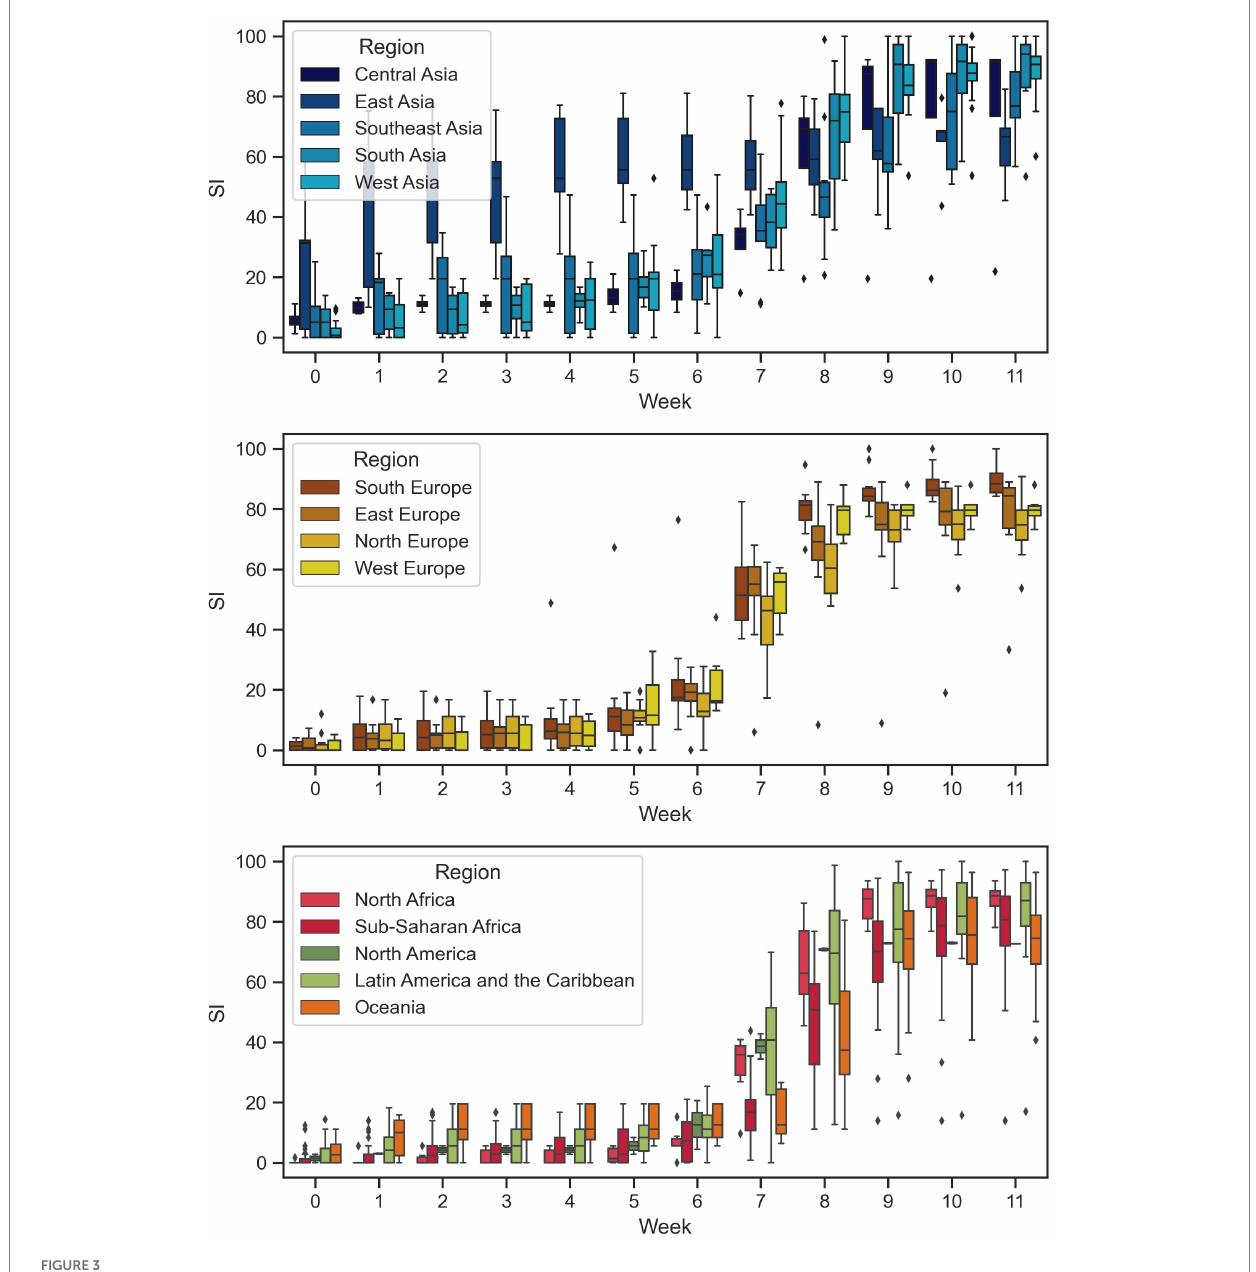
FIGURE 3 Temporal variations of SI across different